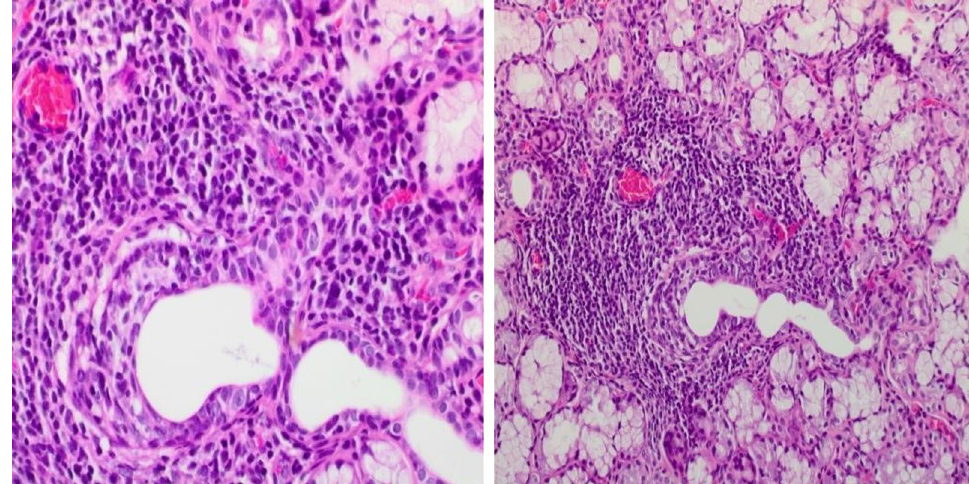
Fig. 2 a H&E 400 lymphoepithelial lesion; b inflammatory focus H&E × Maria Carmen L. F. Silva Santos)